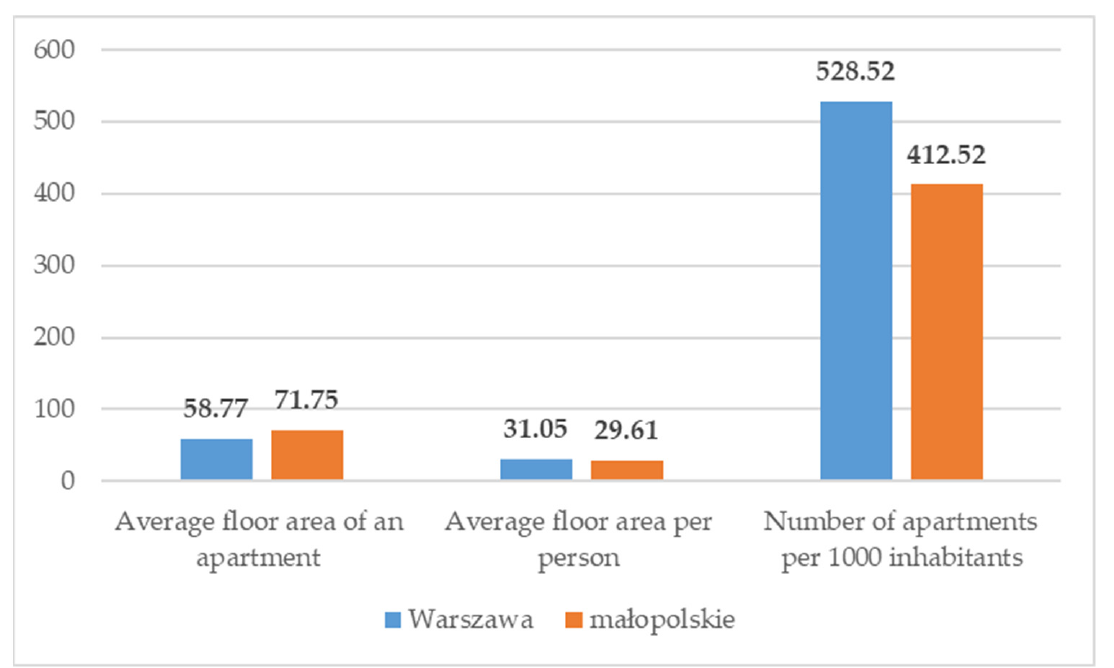
Figure 14. Indicators of housing infrastructure availability in Warsaw and the Mazovian Province.